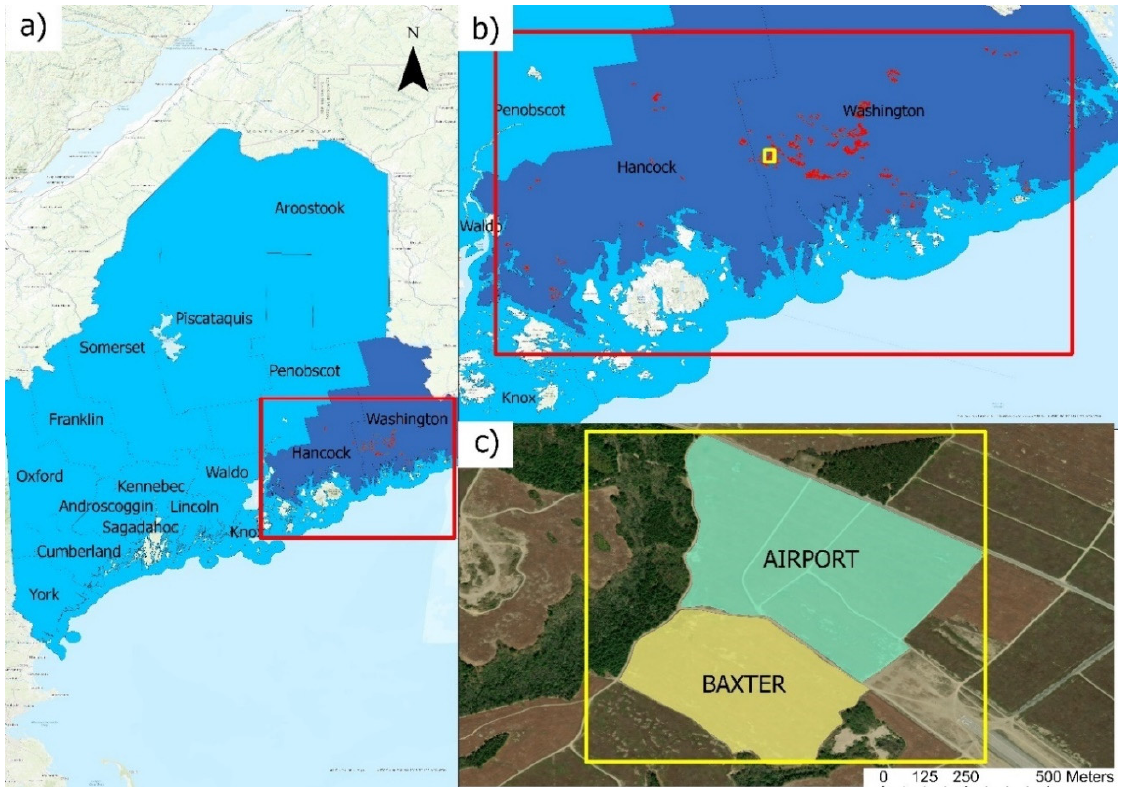
Figure 1. Location of the study sites: ( a ) a map of the state of Maine (light blue color), USA showing the location of the major wild blueberry production region (Washington and Hancock County) in dark blue color; ( b ) a map of the major wild blueberry production region in Maine showing 89 wild blueberry fields in red polygons for this study with an area of 0.06 km 2 (250 m × 250 m) or larger; ( c ) Airport and Baxter wild blueberry fields of Wyman’s in Deblois, Washington County, ME,